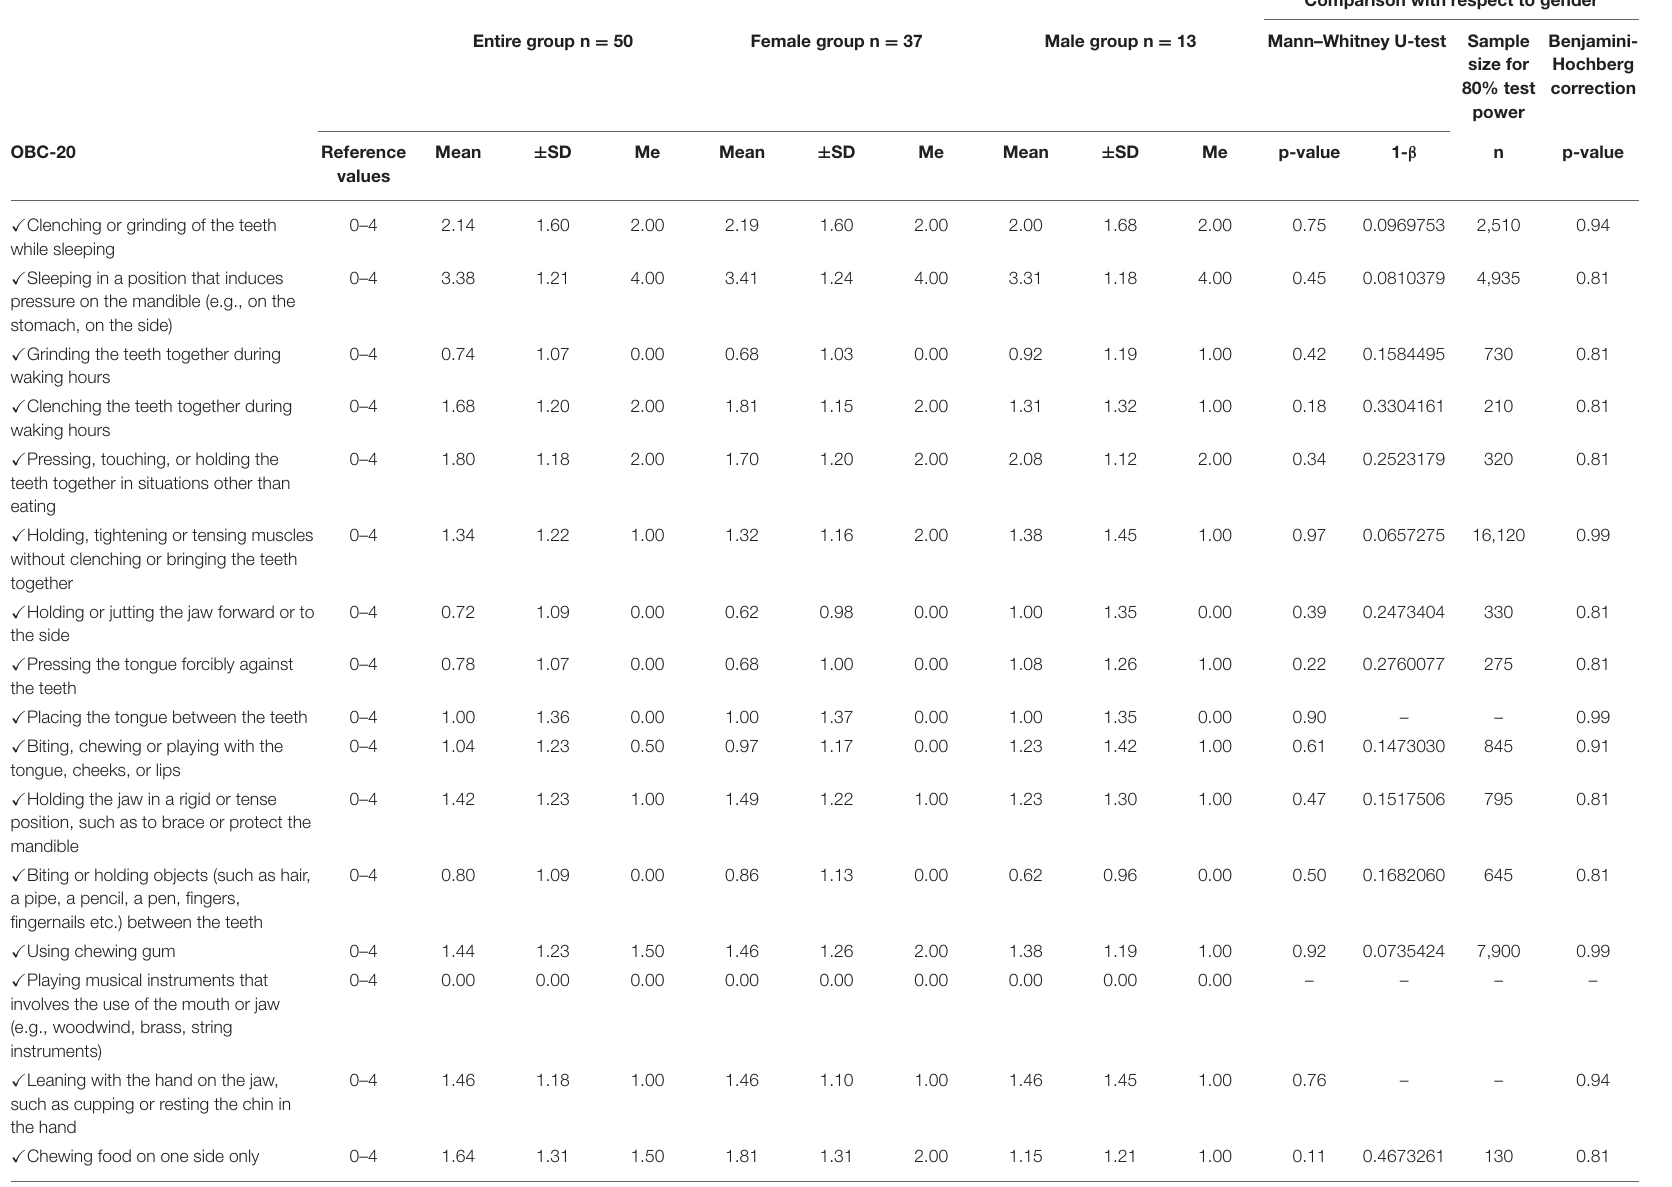
TABLE 7 | Oral behaviors with respect to the oral behavior checklist in the entire study group (n = 50), the group of females (n = 37) and the group of males (n = 13)–Axis II of